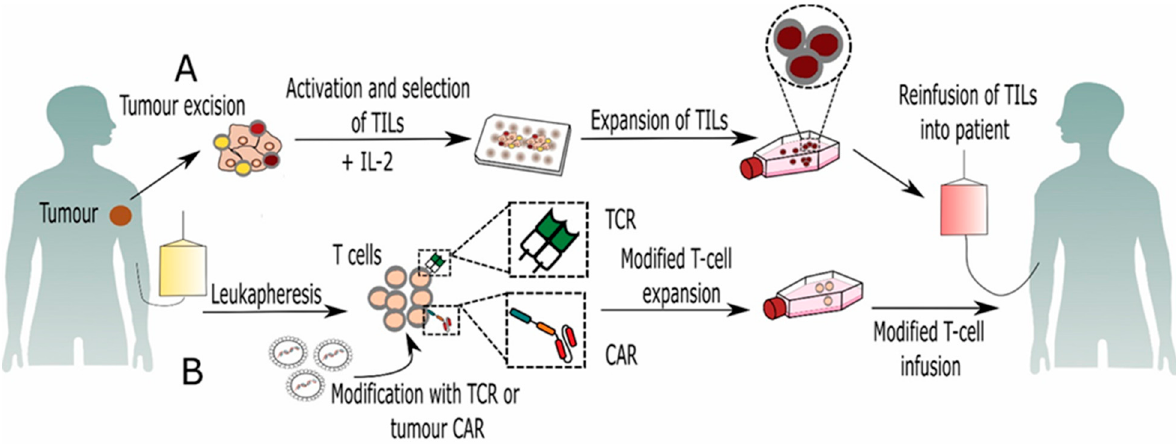
Figure 1. Adoptive T-cell therapy. ( A ) TILs are isolated from excised tumors and expanded with high doses of IL-2. These highly activated TILs are then infused back into the patient following lymphodepleting chemotherapy. ( B ) In TCR/CAR-based ACT, T cells are isolated by leukapheresis and modified to express either TCR or CAR by gene transfection. Modified T cells are expanded ex vivo and infused into the patient.